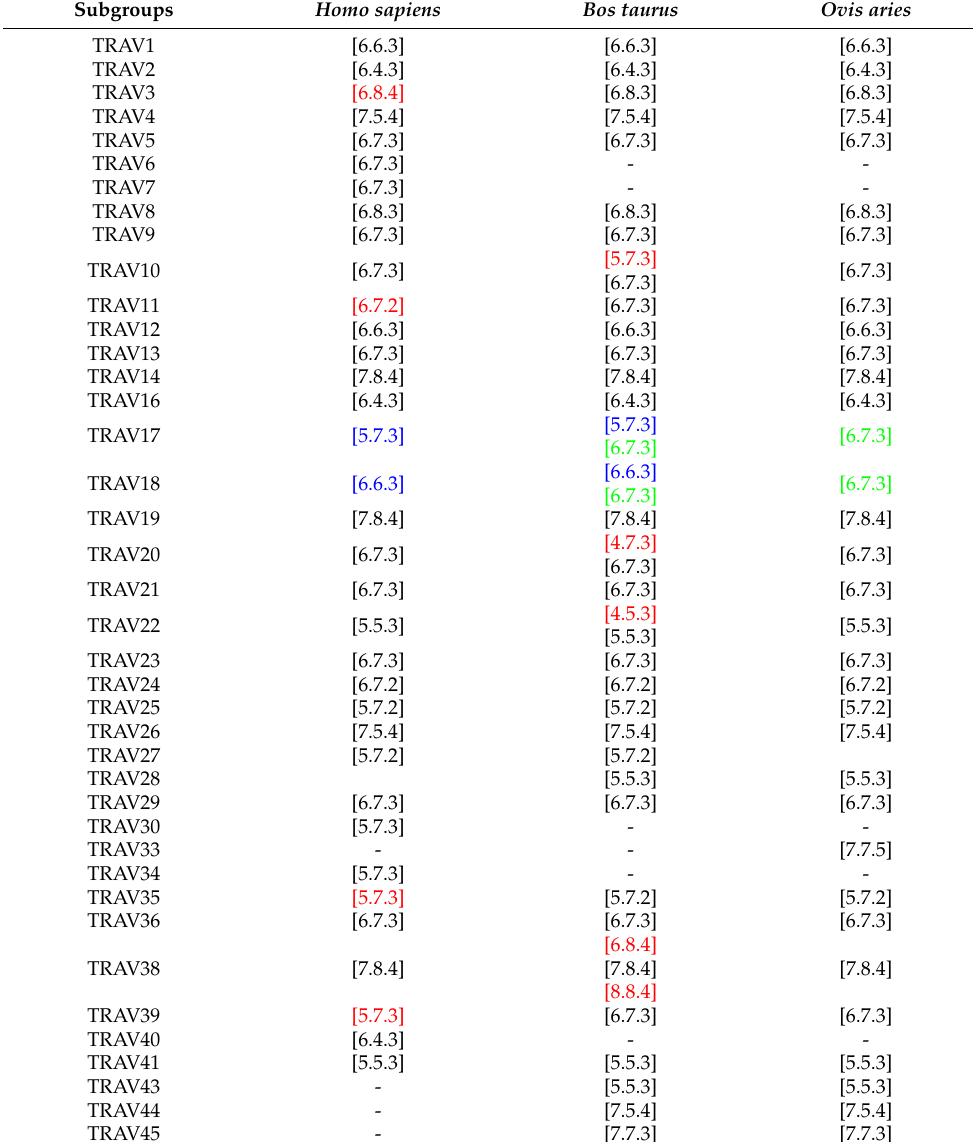
Table 8. TRAV [CDR1-IMGT.CDR2-IMGT.CDR3-IMGT] lengths by subgroup and species in human ( Homo sapiens ), bovine ( Bos taurus ) and sheep ( Ovis aries